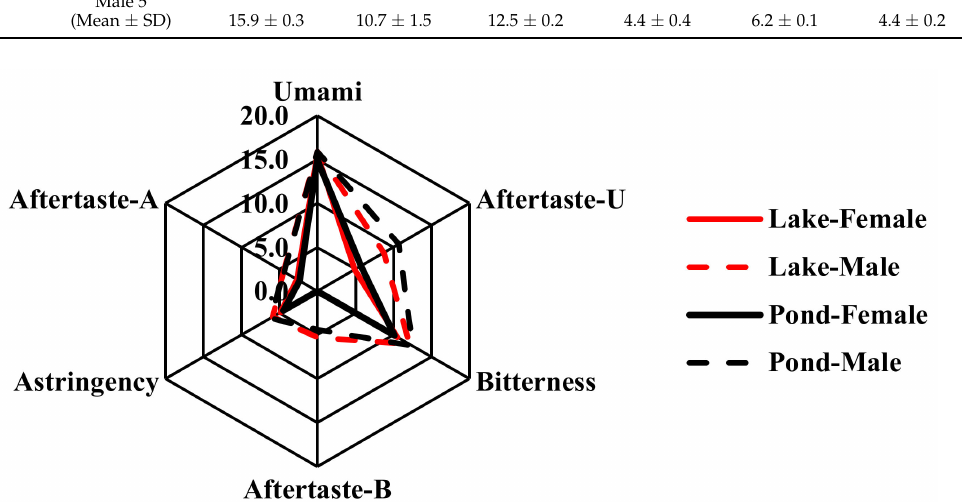
Figure 1. Radar chart of the mean taste values of umami, aftertaste-U, bitterness, aftertaste-B, astringency, and aftertaste-A in the hepatopancreas of June hairy crabs ( Eriocheir sinensis ) from the net enclosure culture area in Yangcheng Lake and aquaculture ponds by the